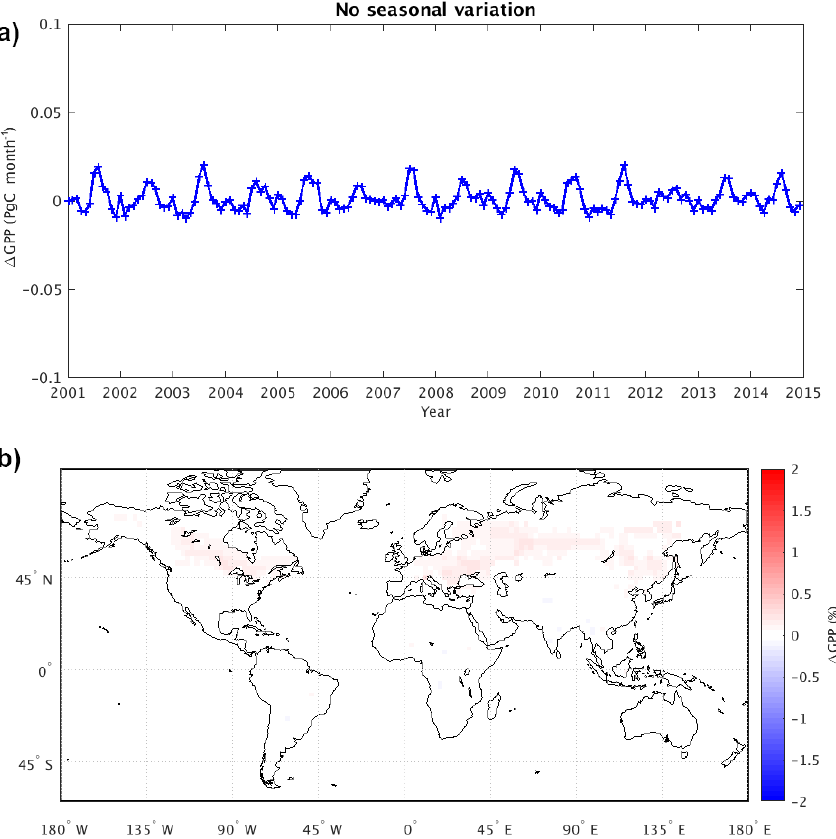
Figure 5. (a) Change in mean global GPP (PgCmonth − 1 ) due to removal of seasonal variability in atmospheric CO 2 concentration (i.e., GPP from the maCO2 experiment minus that from the mCO2 experiment). (b) Map of time-averaged GPP changes as a percentage